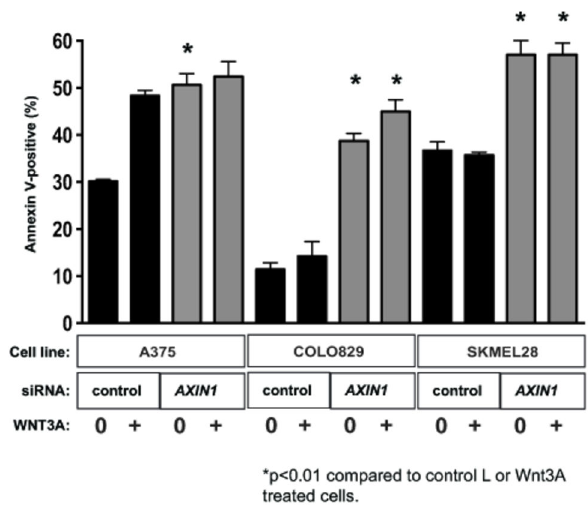
Figure 5. Depletion of AXIN1 sensitizes melanoma cells to TRAIL-mediated apoptosis. Melanoma cell lines indicated were pre-treated with control versus AXIN1 -specific siRNA for 48 hours. Cells were then treated either WNT3A CM or L CM in addition to rhTRAIL (20ng/mL). The percentage of apoptotic cells was determined by Annexin V binding using FACS. Data represents the mean percentage of apoptotic cells at 24 hours post-treatment +/- SEM. P-values were calculated by one-way ANOVA with a Tukey’s post-test analysis. * indicates p <0.05 compared to either L or WNT3A cells treated with control